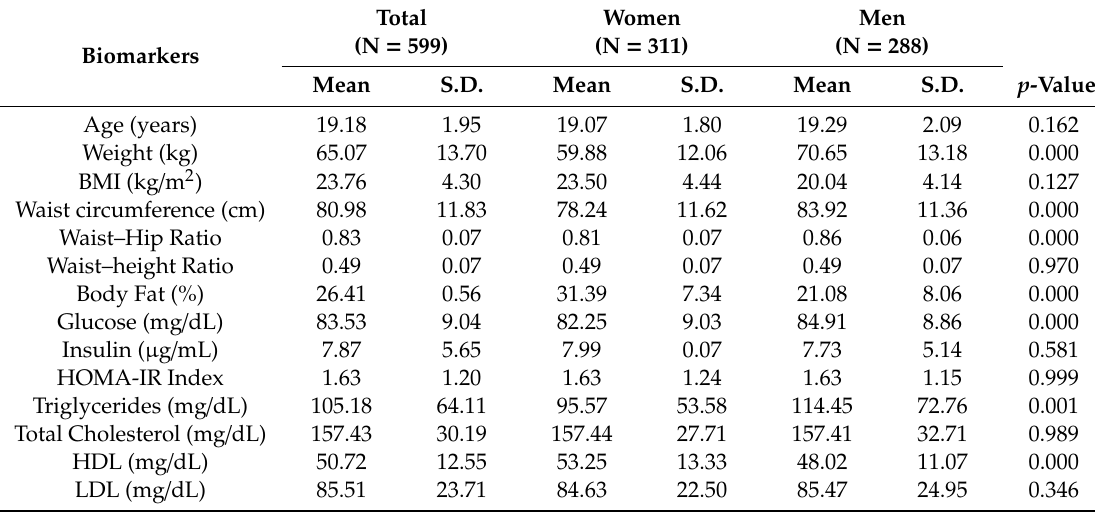
Table 2. General characteristics of the